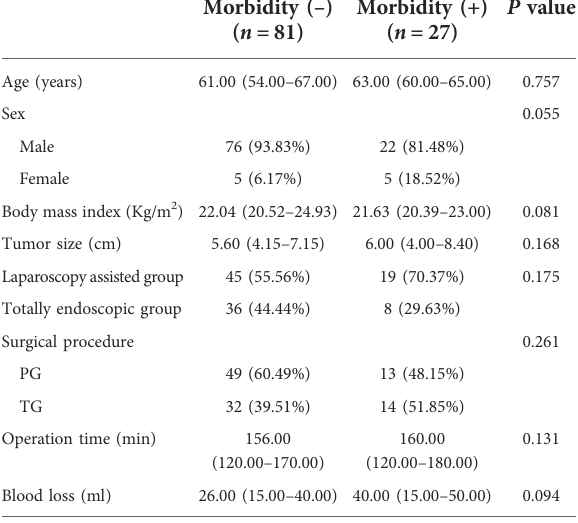
TABLE 7 Clinicopathological factors in patients with or without morbidity ≤ grade III a